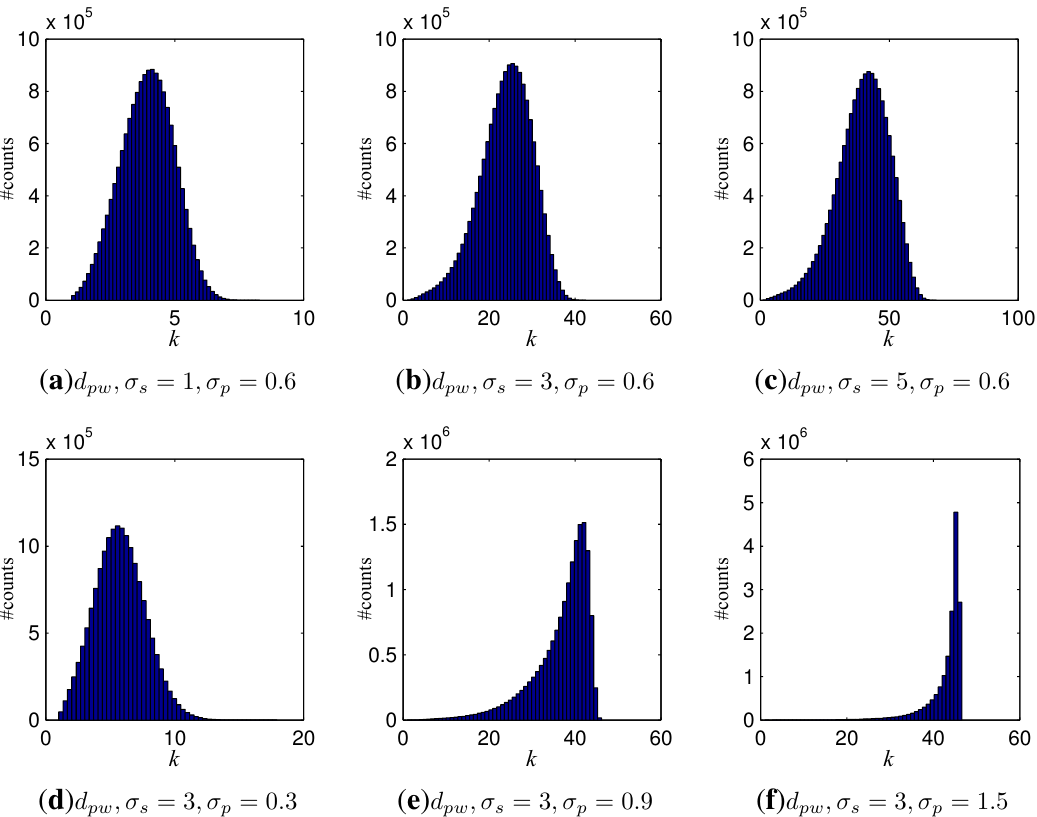
Figure 9. Histograms of the number of averaged pixels k for different σ weight refinement iterations and 11 × 11 local window V . ( a ) d = 3 , σ = 0 . 6 , ( c ) d ( b ) d , σ pw s p